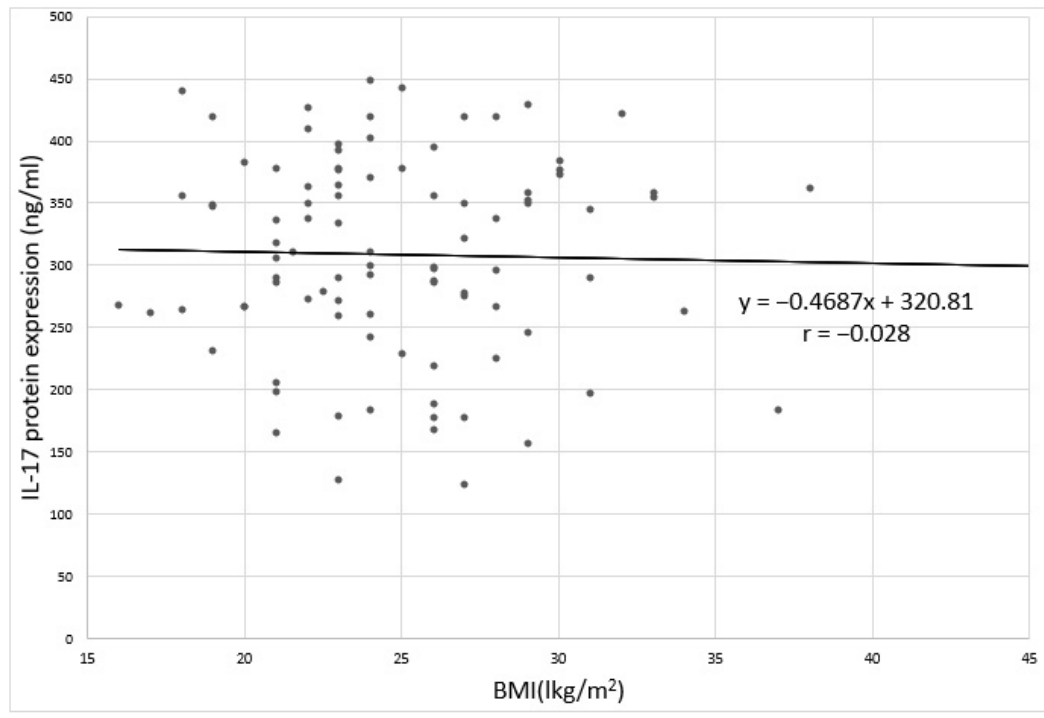
Figure 4. Correlation between IL-17 protein expression and BMI in depressed patients;. r: Pearson’s linear correlation coefficient.